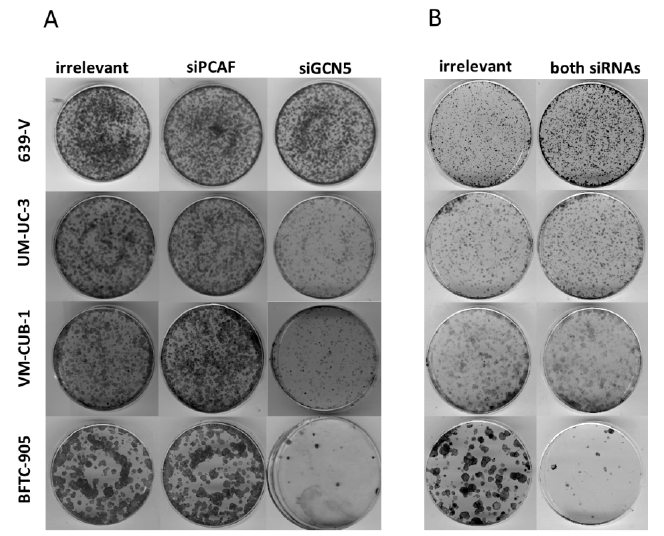
Figure 5. Effects of GNAT siRNA treatment on UCC clonogenicity. Colony formation assays after treatment of the indicated UCCs with siRNAs against GCN5, PCAF ( A ) or both HATs ( B ). Irrelevant designates treatment with non-targeting siRNA. Representative plates from triplicate experiments are shown.